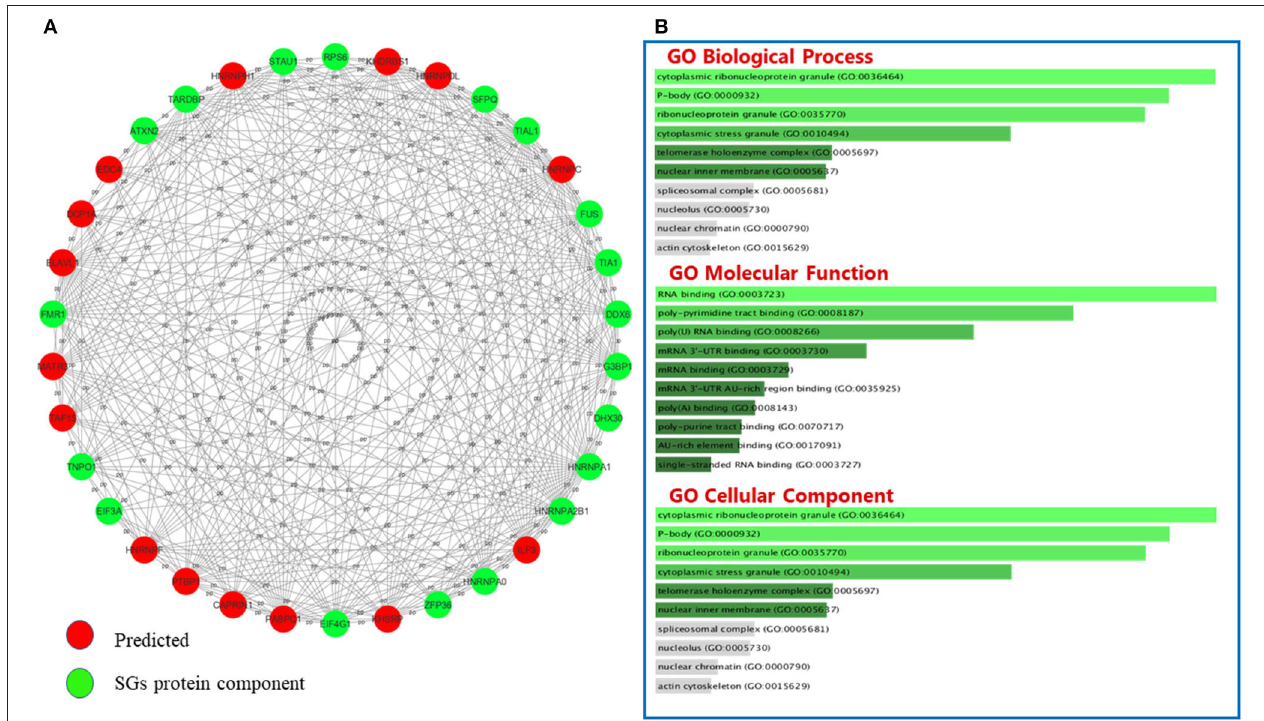
FIGURE 4 | The interactions between SGs protein components and predicted proteins and GO analysis on predicted ones in neurodegenerative disease. (A) Fifteen new proteins were predicted by interaction with SGs protein components using the Cytoscape string-db plugin on data extracted from articles. (B) GO analysis was performed on the predicted proteins in three biological processes: molecular function and cellular component. The length of each bar indicates the importance in that particular category sorted by p -value. Note that the lower the color intensity of the bars, the greater the relationship with that category.